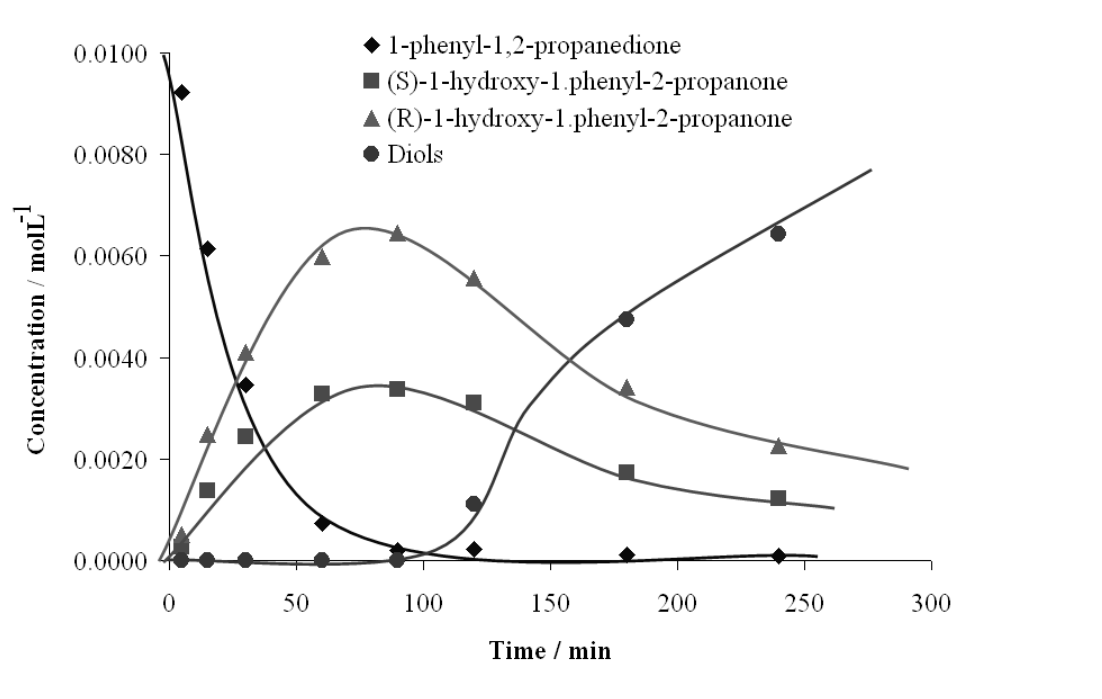
Figure 5. Evolution of the concentration of the substrate and different reaction products during 1-phenyl-1, 2-propanodione hydrogenation. T = 25 ºC, P H